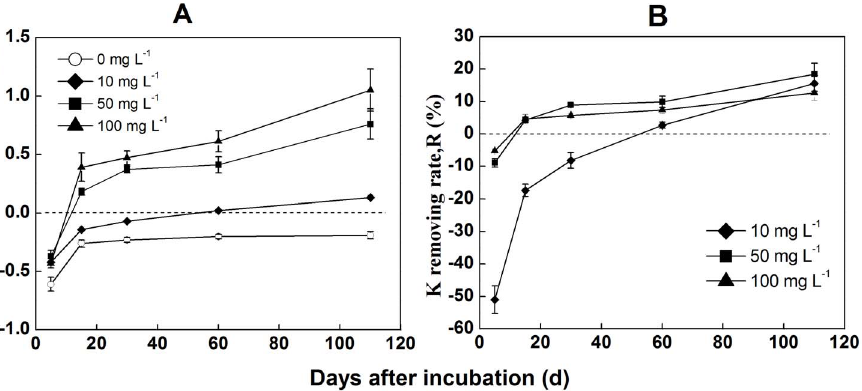
Figure 3. The adsorption of potassium by rice straw residues. The dashed line shows the zero point in the panels. The values are the means of 3 replicates ( 6 standard